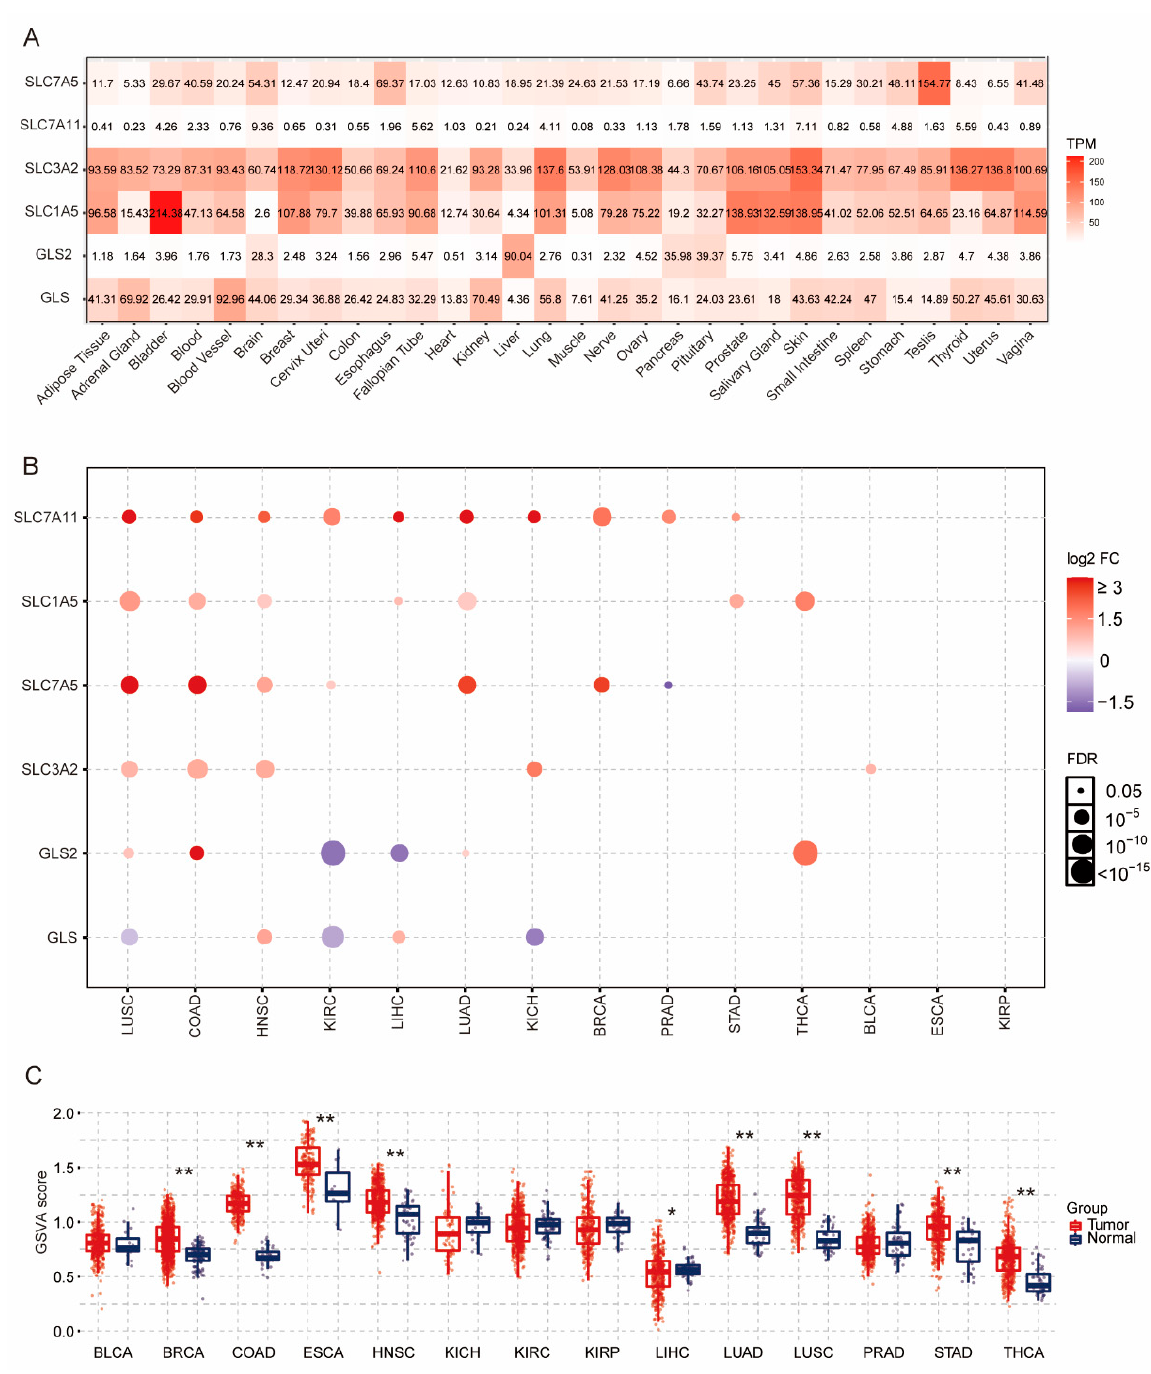
Figure 2. An mRNA expression comparison of glutamine metabolism (GLNM) regulators: ( A ) expression profiles of six GLNM regulators in 30 normal tissues; ( B ) differential expression levels of GLNM regulators between 14 paired normal and tumor tissues. The colors from purple to red represent the fold changes between tumor and normal tissues. Red dots represent higher expression levels of genes in tumor tissues than in normal tissues, while blue dots indicate the opposite expression pattern. The size of a dot indicates the FDR significance, while the value of each dot size is presented on the right side; ( C ) Gene Set Variation Analysis (GSVA) score based on GLNM regulators between 14 paired normal and tumor tissues. * p < 0.05 and ** p < 0.01.